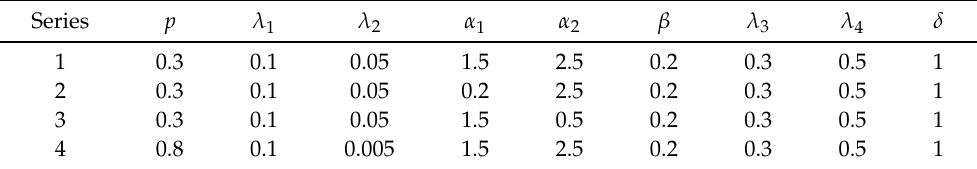
Fig. 1: The Transitions Diagram